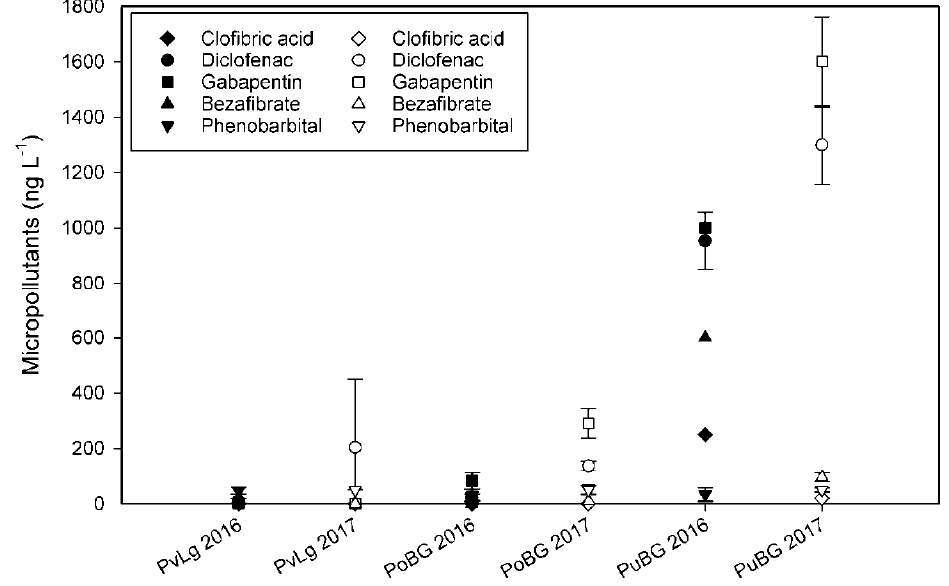
Figure 2. Micropollutant concentrations (ng L − 1 ) in pore water samples at the three sampling sites. The campaign in October 2016 is displayed by closed symbols, whereas the campaign in June 2017 by open